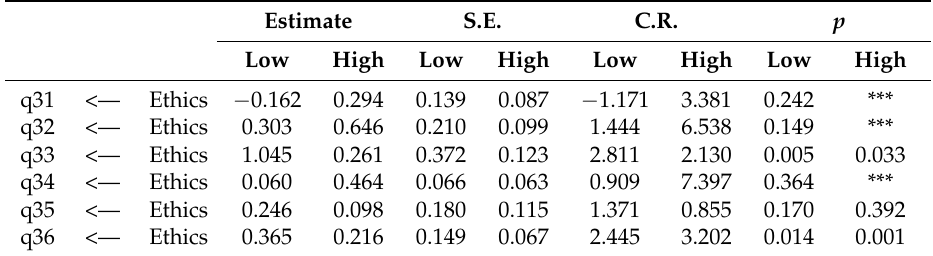
Table 2. Confirmatory factor analysis at low-complexity (low) and high-complexity (high) birthing facilities.